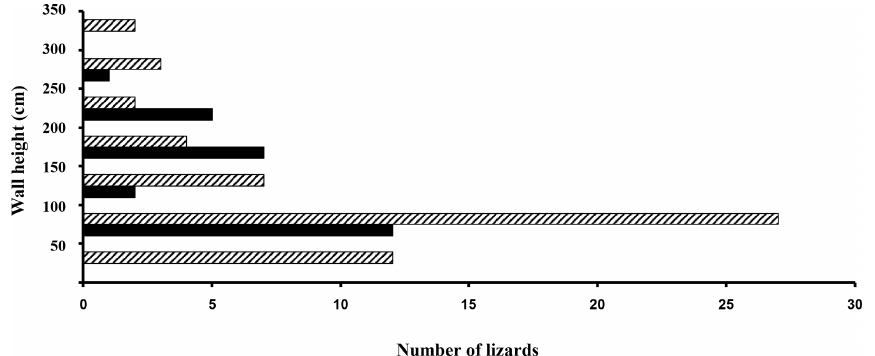
Figure 5. Histograms of lizard heights on the wall next to heat panels (black bars) and those lizards located on unheated wall areas (crosshatched).